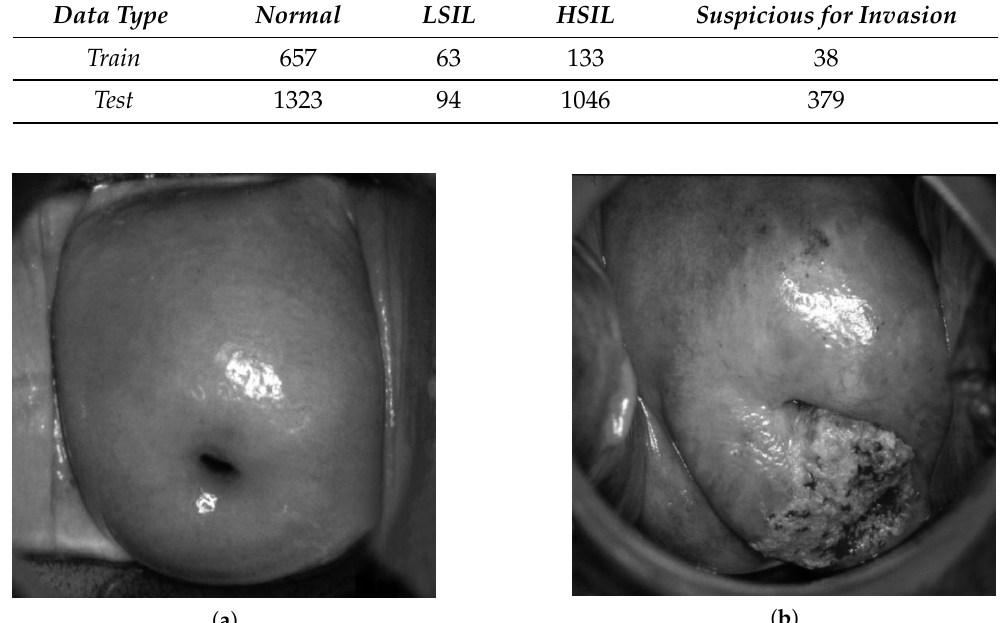
Figure 2. Examples of prepocessing (grayscale) of colposcopic images: normal ( a ) and suspicious for invasion ( b